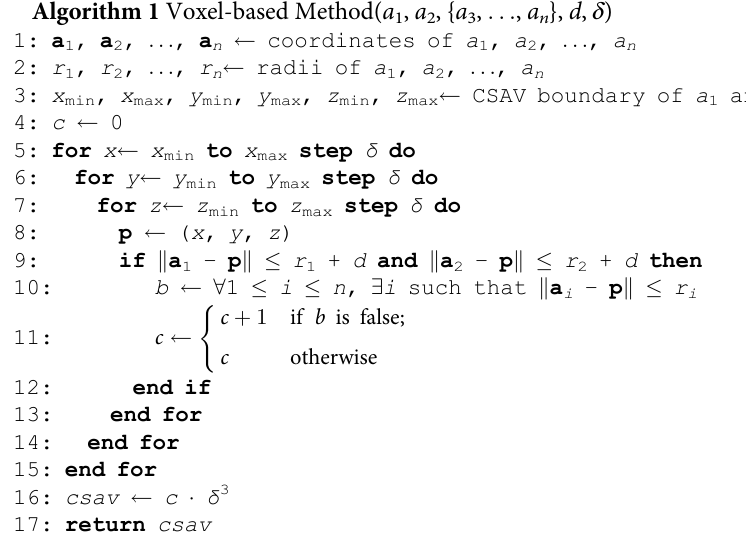
Algorithm 1 Voxel-based Method( a